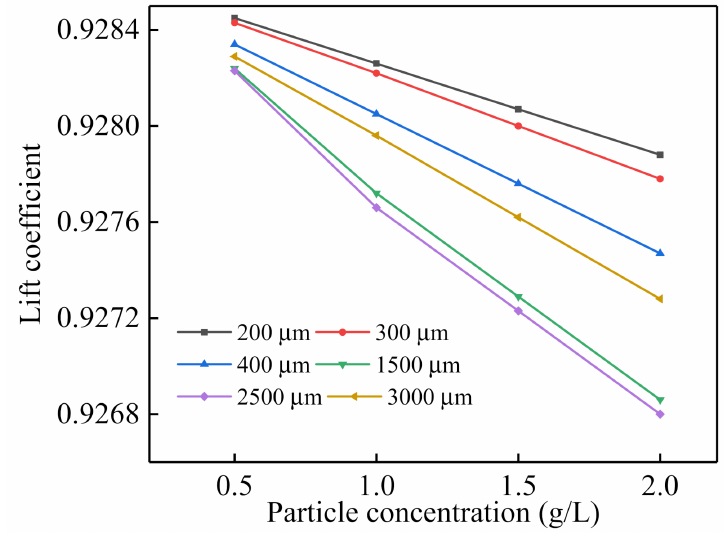
Figure 15. The effect of particle concentration on the airfoil lift coefficient.